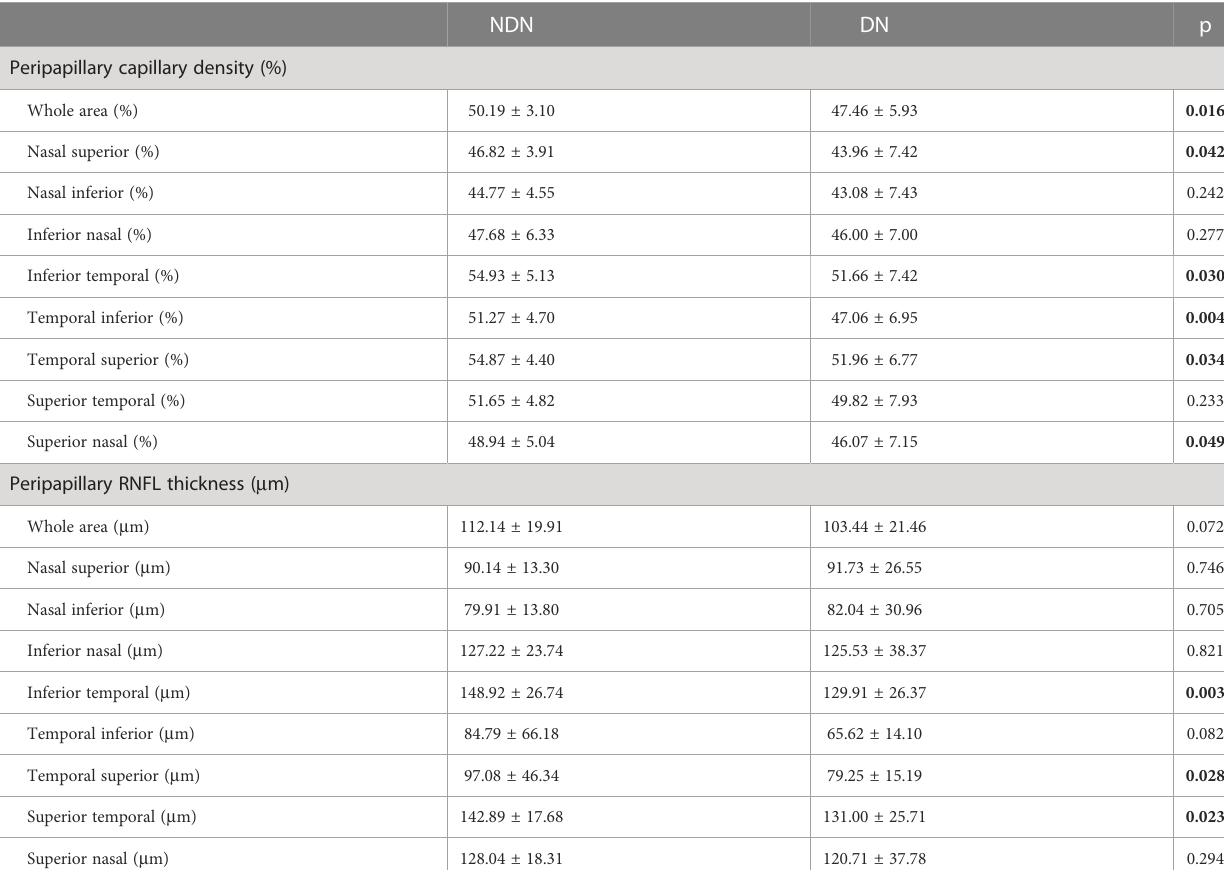
signi fi cantly negative correlation with the FAZ area ( b = − 18.746, p=0.048) and a signi fi cantly positive correlation with the SCP vessel density ( b =0.580, p=0.036). FAZ area, SCP vessel densities (whole area) and GCC thicknesses (perifoveal) were included in the multivariate linear regression analysis for blood creatinine. The level of blood creatinine showed a signi fi cantly negative correlation with the SCP vessel density ( b =-1.024, p=0.003) consequently. The multivariate linear regression analysis for urinary protein included SCP and DCP vessel densities (whole area), and fi nally showed that